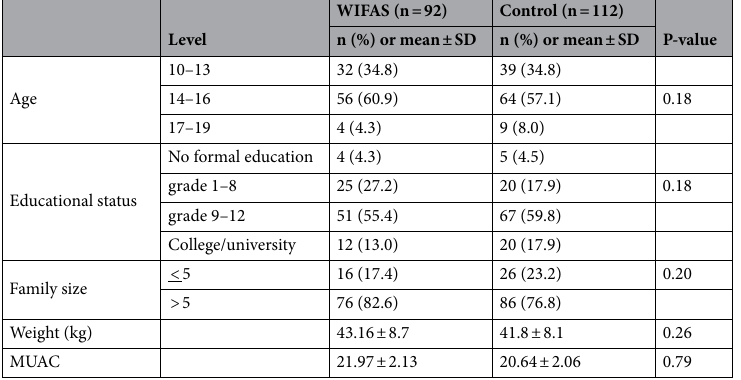
Table 1. Socio-demographic characteristics of the adolescent girls. MUAC , mid-upper arm circumference, WIFAS weekly iron-folic acid supplementation.